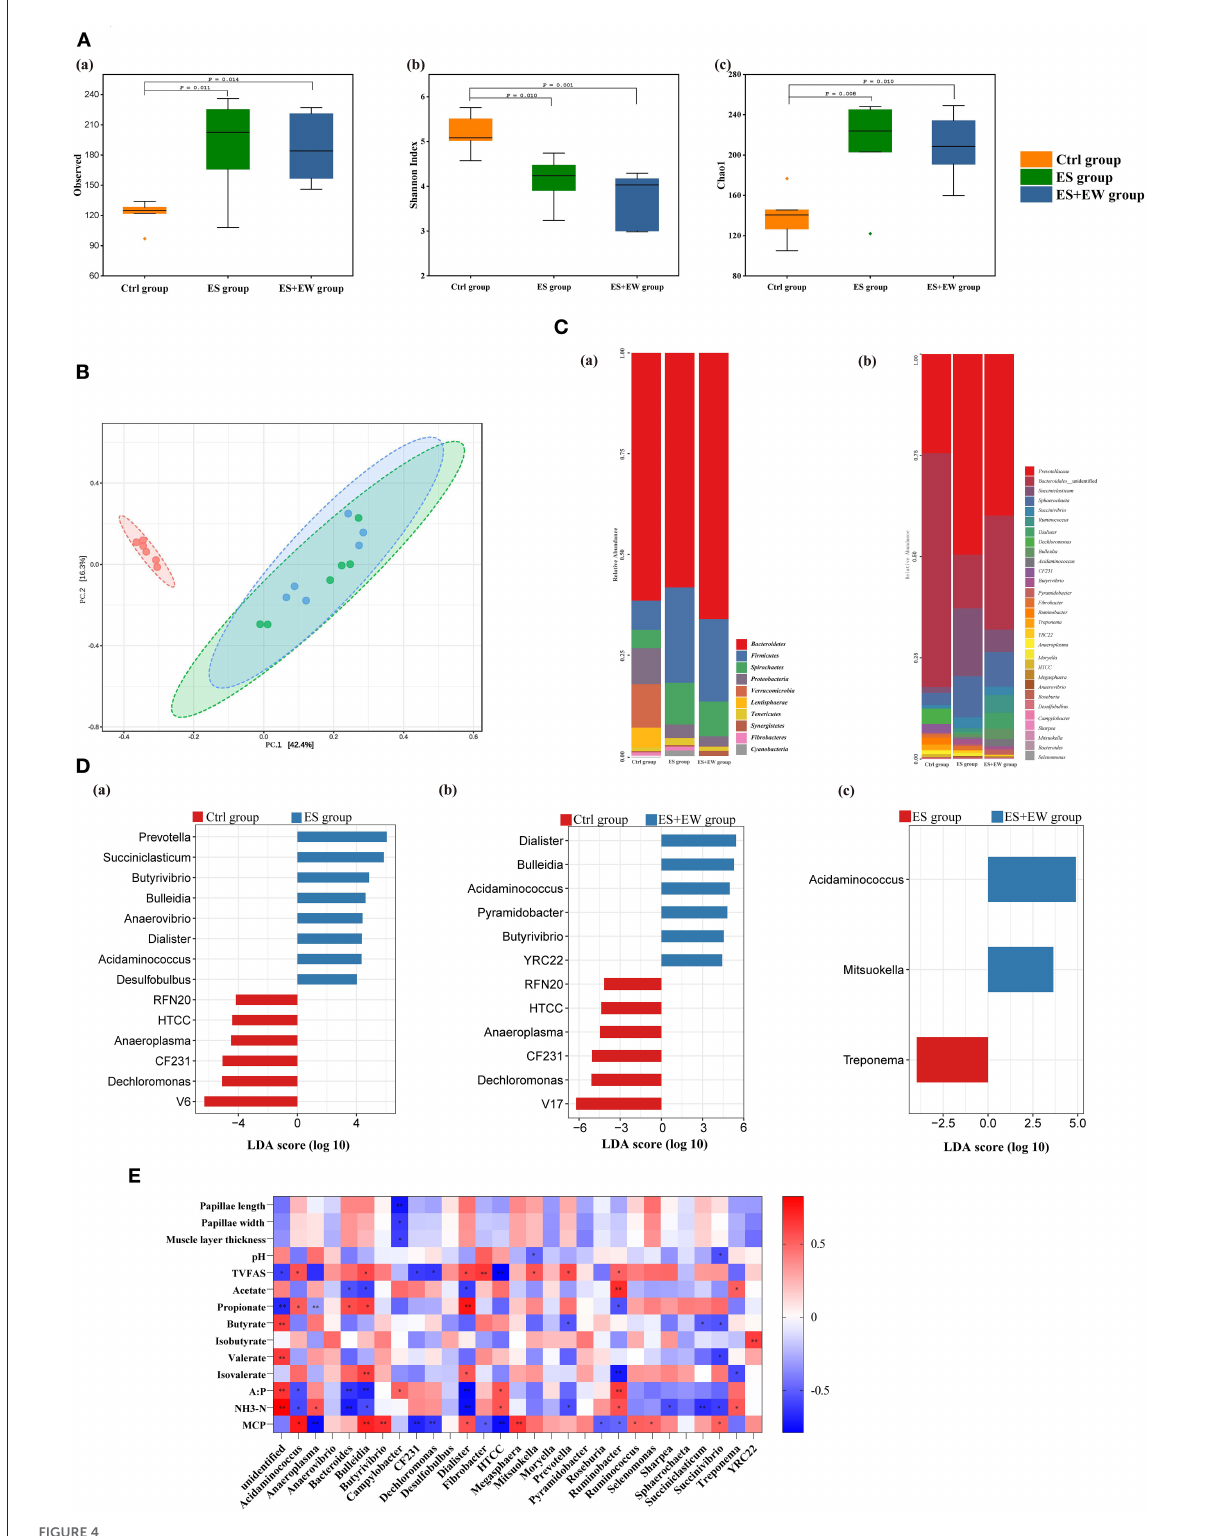
FIGURE4 Ruminal microbiota diversity and community structure of lambs in different early feeding strategies at 42 days of age. (A) The alpha diversity in the rumen microbial community based on the observed species (a) , Shannon index (b) and Chao1 index (c) . (B) The principal coordinate